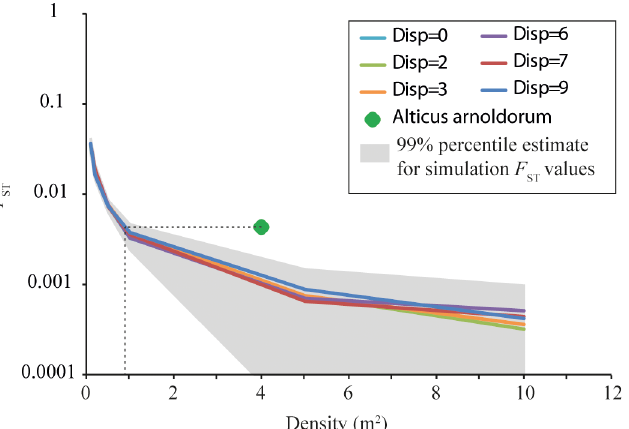
Fig 5. Results of simulation analyses of A . arnoldorum around Guam illustrating the relationship between density (m 3 ) and F ST . Each coloured line represents a different dispersal scenario employed in simulations and the green diamond represents the global empirical F ST for A . arnolodorum . Dispersal distribution ‘ 0 ’ , ‘ 2 ’ , ‘ 3 ’ , ‘ 6 ’ , ‘ 7 ’ , and ‘ 9 ’ correspond to mean squared parent-offspring dispersal distances of 10 m, 40 m, 100 m 200 m, 1000 m